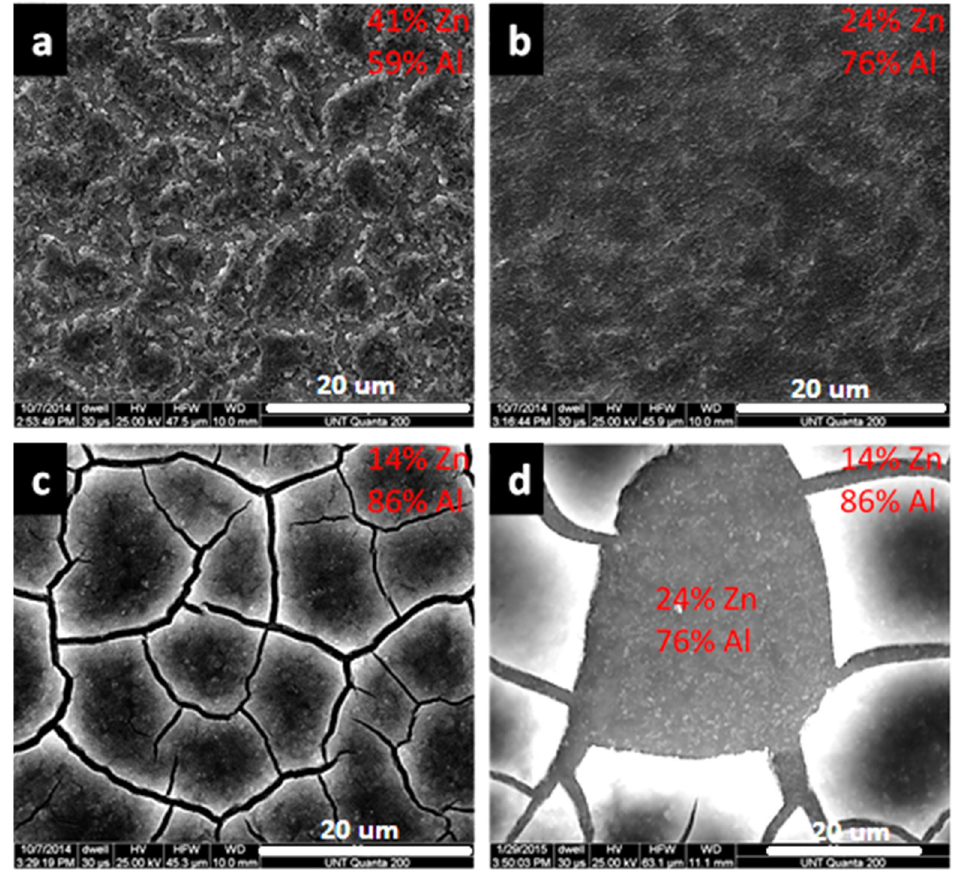
Figure 3. SEM images of modified zaccagnaite films for ( a ) 1L, ( b ) 2L, ( c ) 5L, and ( d ) 5L film with a portion of top phase removed (L = layer). (Image bars are 20 μ m). Table 1. Elemental composition measured by EDS and thickness of the electrodeposited films (n = 3). Number of